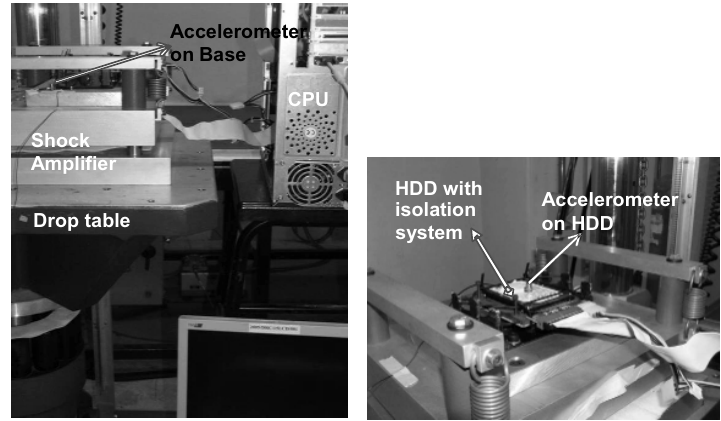
Fig. 4. Experiment set up for vertical shock test.